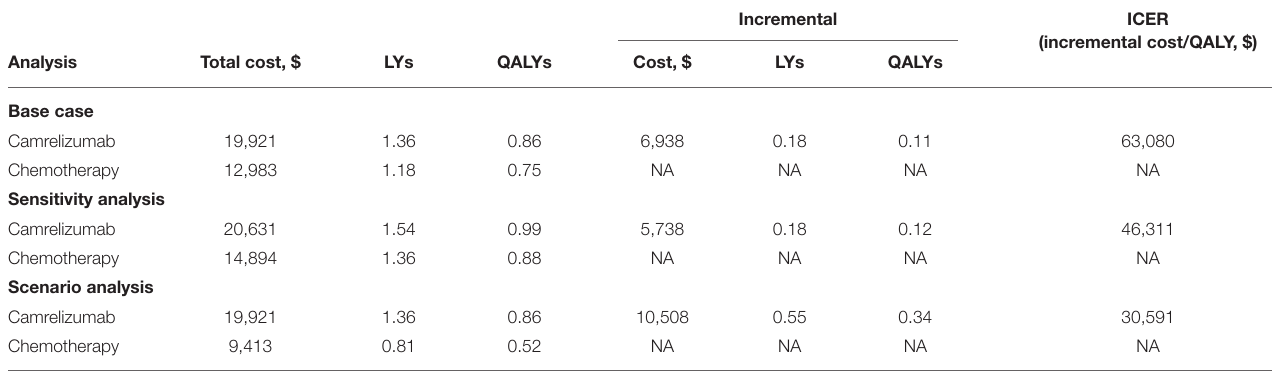
Incremental ICER (incremental cost/QALY, $)